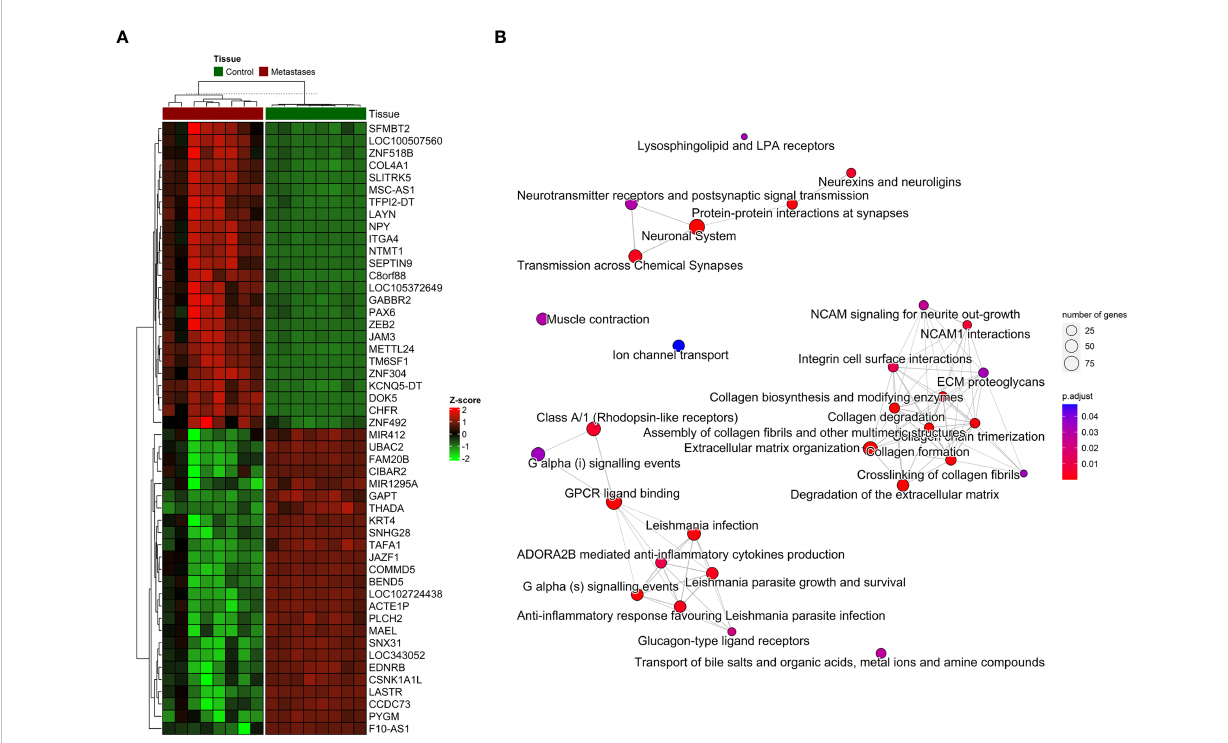
FIGURE 4 The distribution of DNA methylation patterns. (A) Heatmap of top 25 signi fi cantly hypermethylated and top 25 signi fi cantly hypomethylated genes between metastasis and adjacent liver tissue. (B) Emapplot of the overrepresentation analysis (ORA) pathway enrichment according to the Reactome